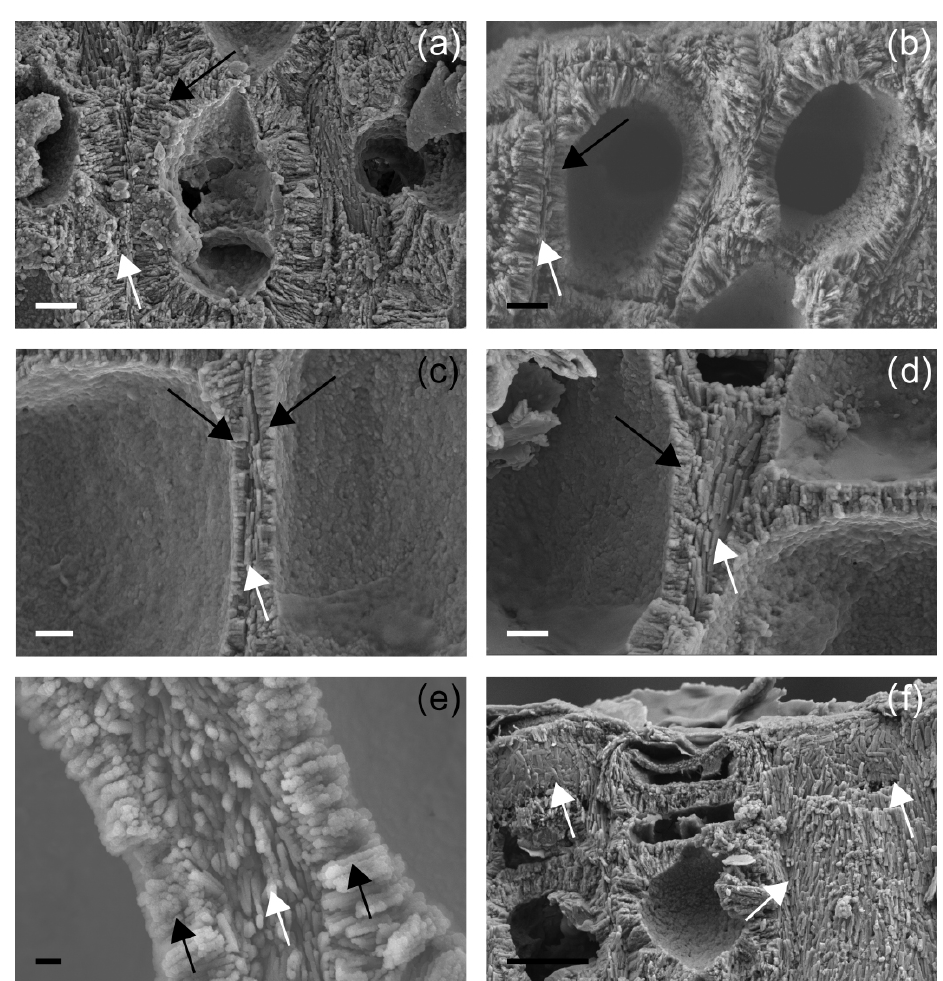
Figure 5. Details on primary wall (PW) in longitudinal section. (a) Thick-walled short cell showing both PW (white arrow) and SW (black arrow) for Santa Caterina shoal. Scale bar = 2µm. (b) Thick-walled short cell showing both PW (white arrow) and SW (black arrow) for Pontine Islands. Scale bar = 2µm. (c) Thin-walled long cell showing both PW (white arrow) and SW (black arrows). PW crystals in longitudinal section appear with elongated shape for Santa Caterina shoal. Scale bar = 1µm. (d) Thin-walled long cell showing both PW (white arrow) and SW (black arrow). The fracture shows detail of tiles composing the PW (white arrow) for Santa Caterina shoal. Scale bar = 1µm. (e) Details of multi-layered PW (white arrow) and SW (black arrows). PW crystals in longitudinal section appear as elongated crystals for Pontine Islands. Scale bar = 0.2µm. (f) Perithallial and epithallial cells in which the longitudinal section is locally tangential to the PW (white arrows). Crystals appear as flat rectangular tiles for Santa Caterina shoal. Scale bar =